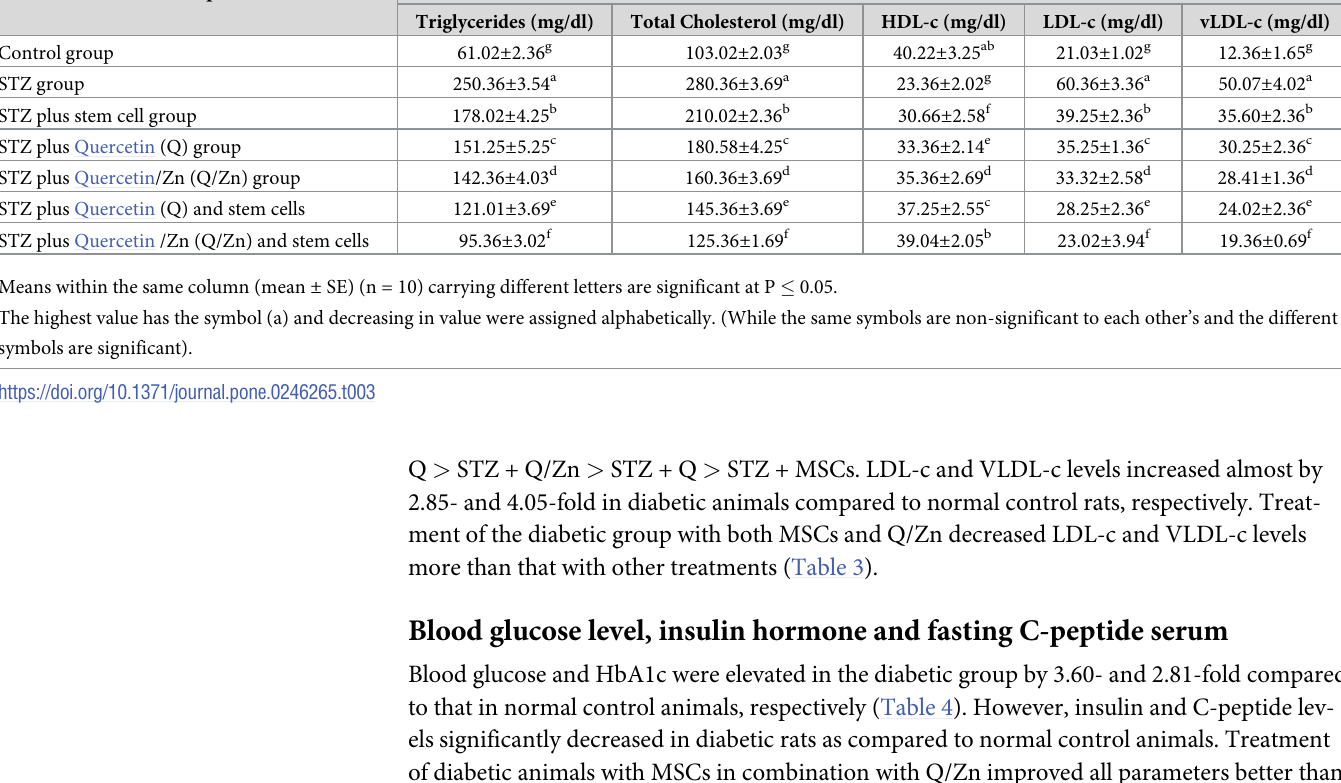
Table 3. Lipid profile picture of control and treated male rats with quercetin, quercetin/Zn, or stem cells and their combinations. Groups